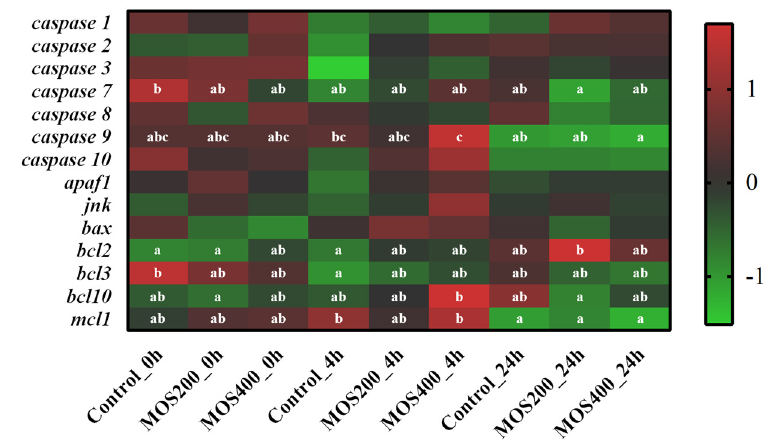
Figure 7. Heatmap of apoptosis-related genes based on DGE profiling. The color values represented up-regulated (red) and down-regulated (green) expressions of selected DEGs, which ranged from 1 to − 1. Different alphabets indicate statistically significant differences after performing Tukey’s HSD test ( p < 0.05).